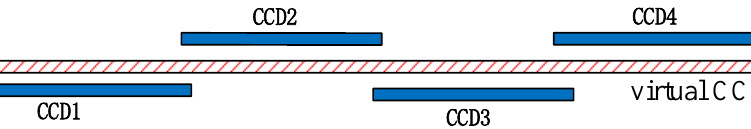
Figure 2. The diagram of Virtual CCD and real CCD relative position.